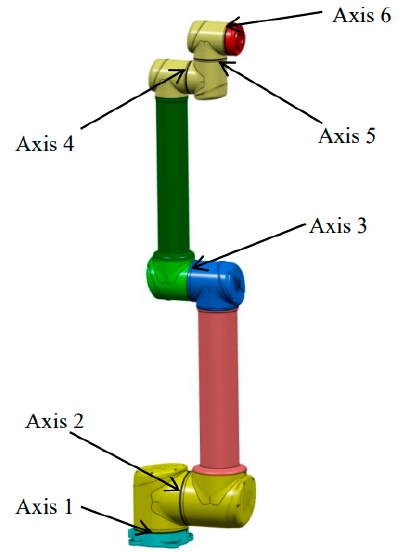
Figure 3. The six joint axes of the UR10 robot.